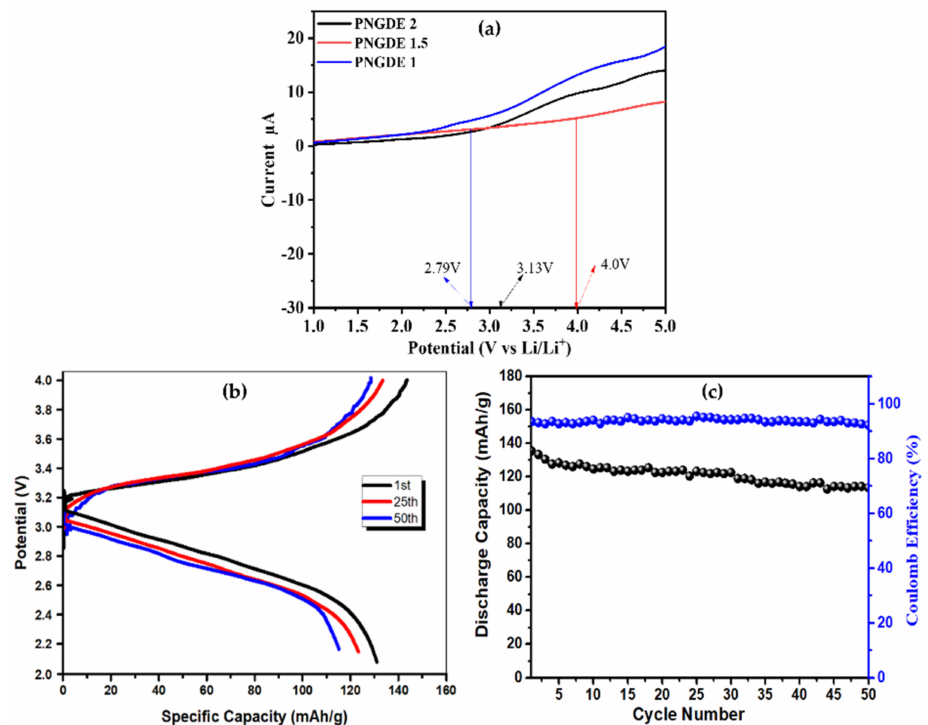
Figure 5. ( a ) LSV profiles of PNGDEs at scanning rate 0.1 mV/s from 1.0–5.0 V. ( b ) CD plots of the LiFePO 4 /PNGDE 1.5/LFP cell at 0.2 C. ( c ) Cycling performance of the LiFePO 4 /PNGDE 1.5/Li cell at 0.2 C after 50